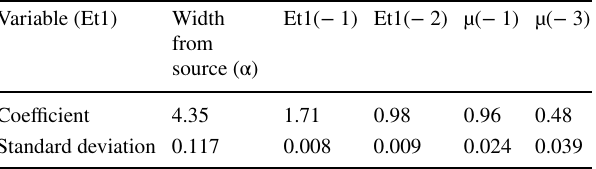
Table 1 Conditional mean equation evapotranspiration by the FAO Penman–Monteith method